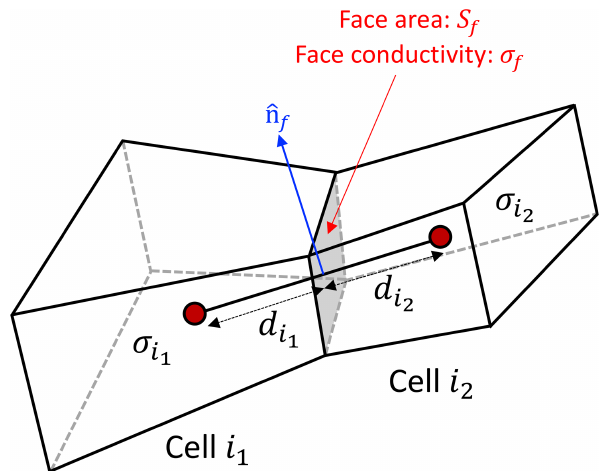
Figure 1. Two adjacent FV cells i 1 and i 2 having conductivity σ i and σ i , respectively. The distances of the common face f from the 2 center of cells i 1 and i 1 , respectively, are d i